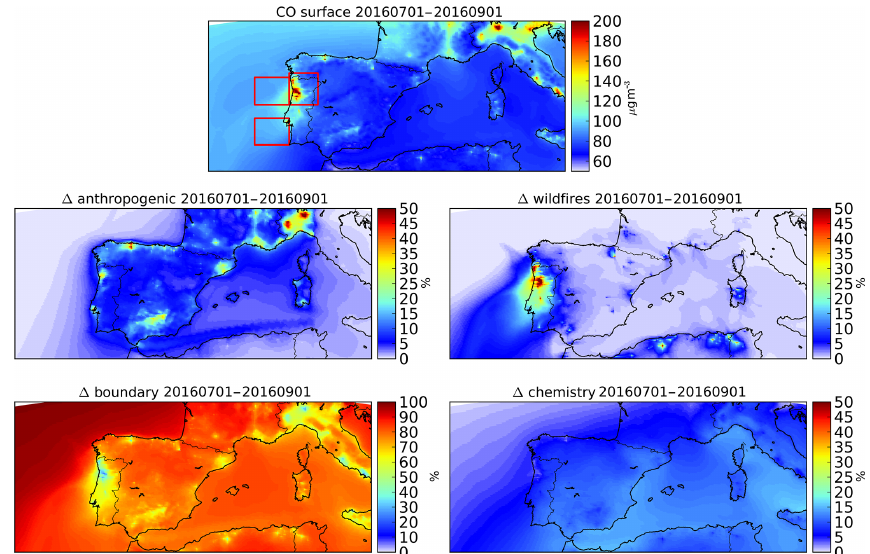
Figure 9. Average surface concentration of CO simulated by CHIMERE during July–August 2016 (top) and relative contributions from the main contributing CO tracers: from primary anthropogenic (anthropogenic) and biomass burning (wildfires) emissions, boundary conditions (boundary), and chemical production (chemistry). The red squares on the top map delimit the regions used for the evaluation of the fire plume simulation against satellite observations.